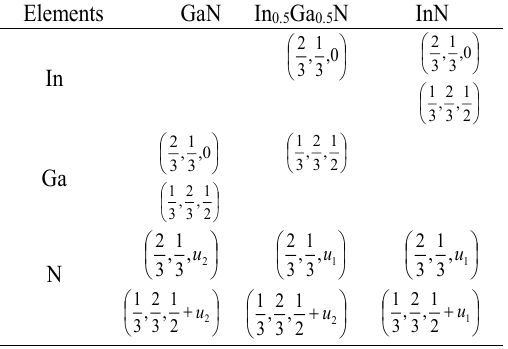
Table 2. Structural parameters which using for